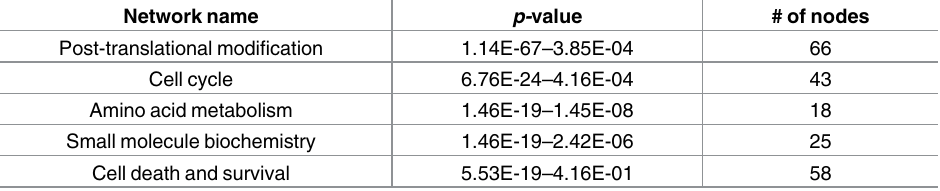
Table 1. Biological pathways with enrichment of differentially